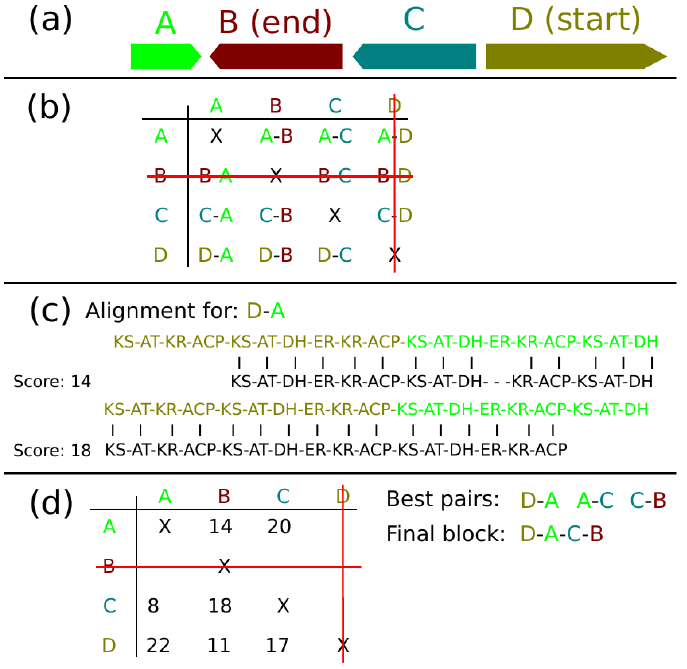
Figure 7. Demonstration of the module order algorithm. ( a ) Example blocks which cannot be combined since they are on different strand sides or far apart in the cluster. ( b ) An all-vs.-all matrix which generates hypothetical combined block pairs. Each block can be either at the beginning or the end of the newly generated block. Unreasonable combinations are excluded, marked with a red line. ( c ) A hypothetical example of 2 alignments performed for the D-A block combination. Each combination is scored with 252 reference BGCs. ( d ) Based on the score assigned to each block pair, the best scoring pairs are extracted and combined to the final block.